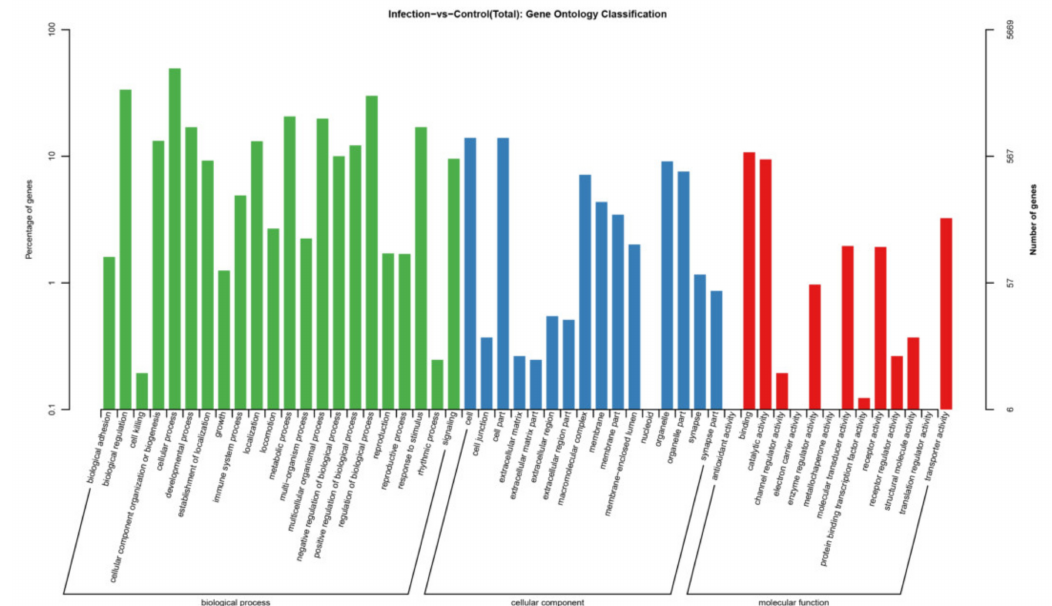
Figure 5. GO analysis of the target genes of the dysregulated